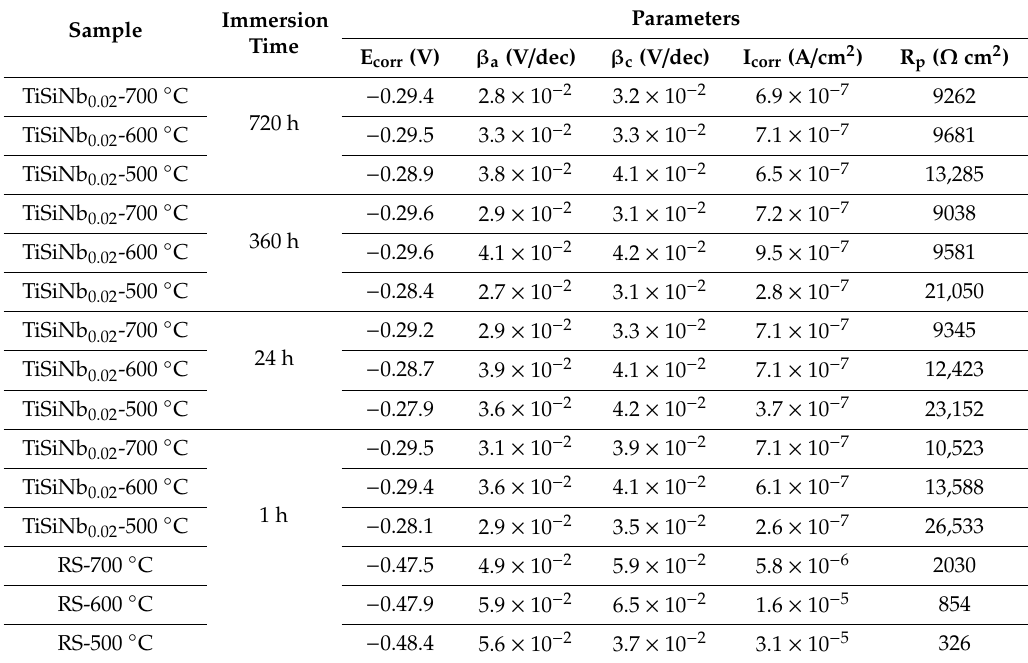
Figure 7. Potentiodynamic electrochemical polarization (PEP) ( a ), electrochemical impedance spectroscopy (EIS) ( b ) curves with equivalent electrical circuit (EEC) ( c ) of annealed RS at 500 ◦ C, 600 ◦ C and 700 ◦ C in N 2 atmosphere after 1 h immersion in standard condition solution (SCS). Table 3. Electrochemical parameters of annealed RS and TFSOC in N 2 atmospheres at mentioned temperatures after immersion for 1, 24, 360 and 720 h in